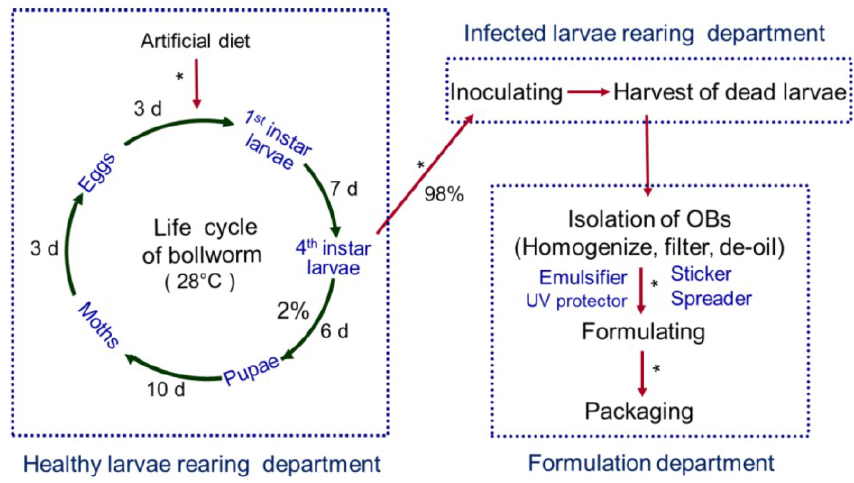
Figure 1. Schematic representation of the production of HearNPV insecticide. The steps with an asterisk ( * ) can be implemented by